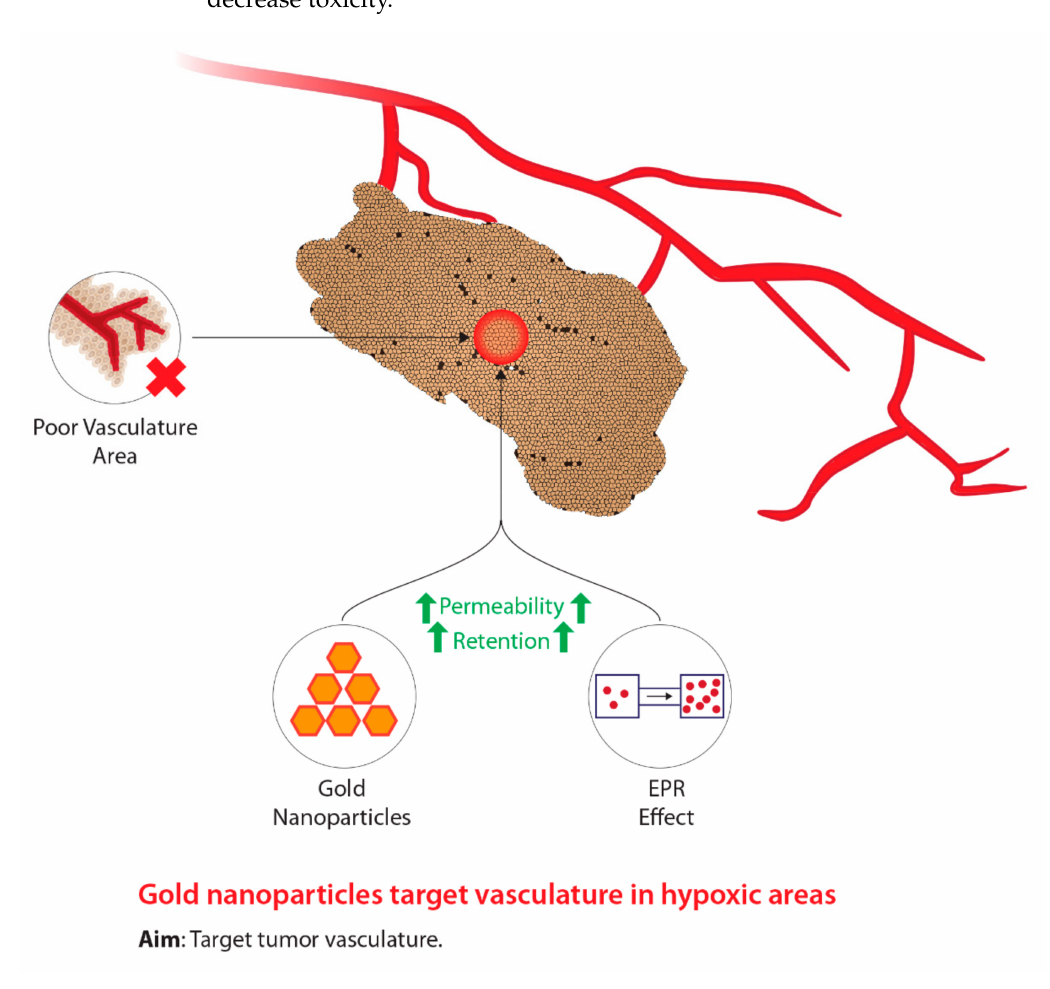
Figure 3. The concept underlying the use of gold nanoparticles in the treatment of tumour hypoxia during